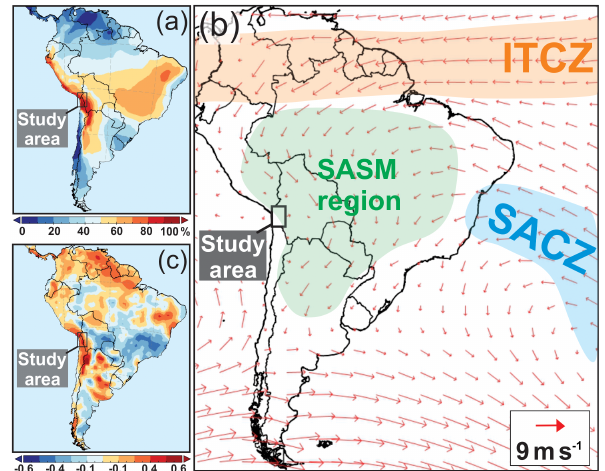
Figure 2. South American atmospheric features based on reanalysis data. (a) Summer (DJFM) percentage of the total annual precipita- tion amount based on the ERA-40 reanalysis dataset (1980–2017), (b) mean summer (DJFM) wind fields (ms − 1 ) at 850hPa for the 1980–2017 period from the ERA-Interim reanalysis, and (c) corre- lation (1980–2017) between South America summer precipitation (DJFM) and the Southern Oscillation Index (SOI) during the austral summer (DJFM). All precipitation data correspond to the ERA-40 reanalysis dataset, which is freely provided by the European Centre for Medium-Range Weather Forecasts (ECMWF). The SOI is freely provided by the National Oceanic and Atmospheric Administra- tion (NOAA), USA. ITCZ: Intertropical Convergence Zone, SACZ: South Atlantic Convergence Zone, SASM: South American sum- mer